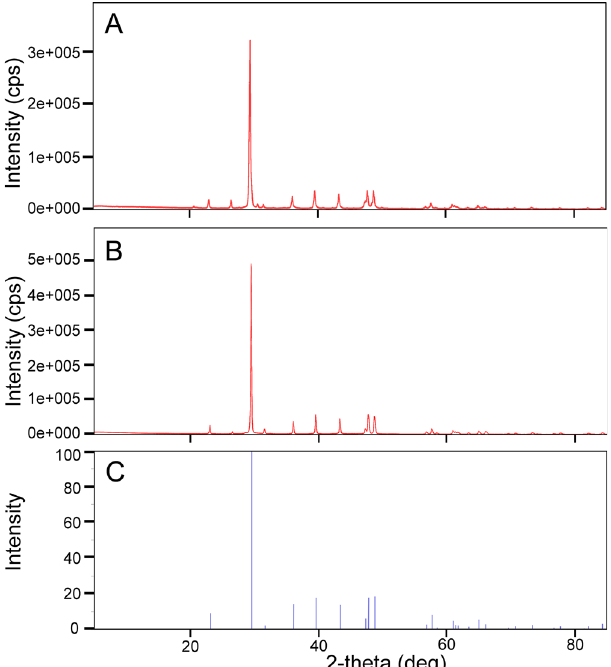
Figure 4. X-ray diffraction analyses of fossil ( A ) and modern ( B ) sand dollar S. mirabilis compared with the standard spectrum of high Mg calcite ( C ). Figure was edited and the line thickness was enhanced with Adobe illustrator CS6 (https:// www. adobe. com/ produ cts/ illus trator.